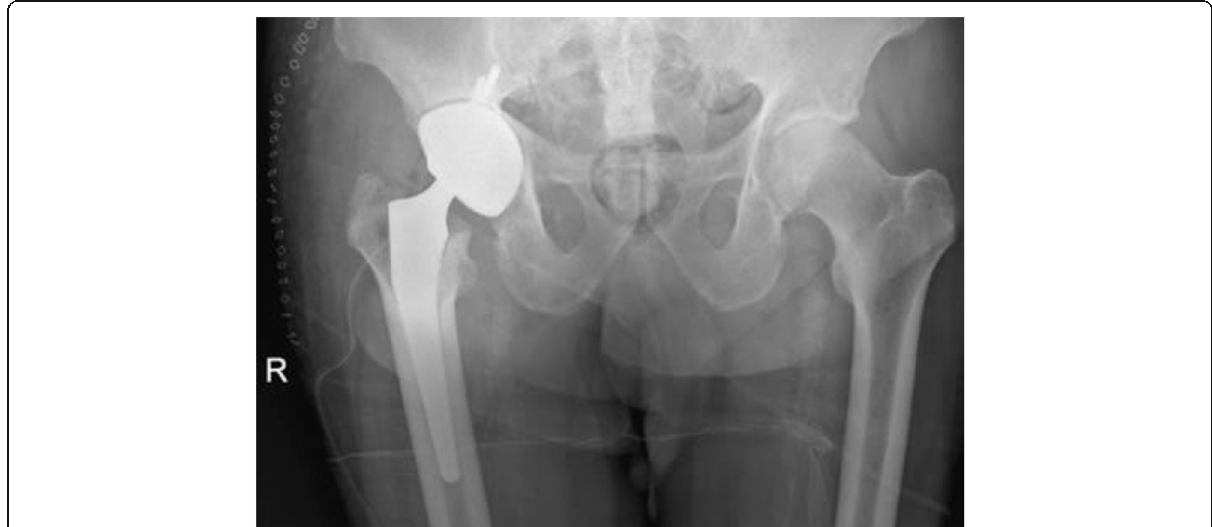
Fig. 3 Definitive prosthesis after 9